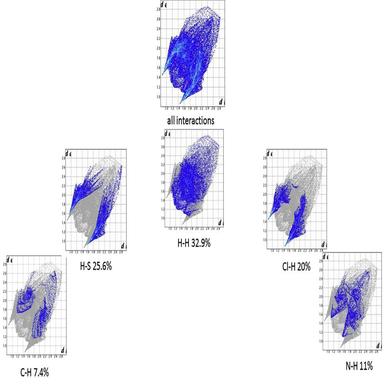
Two-dimensional fingerprints plots of tetrakis(thiourea)cobalt chloride crystal.